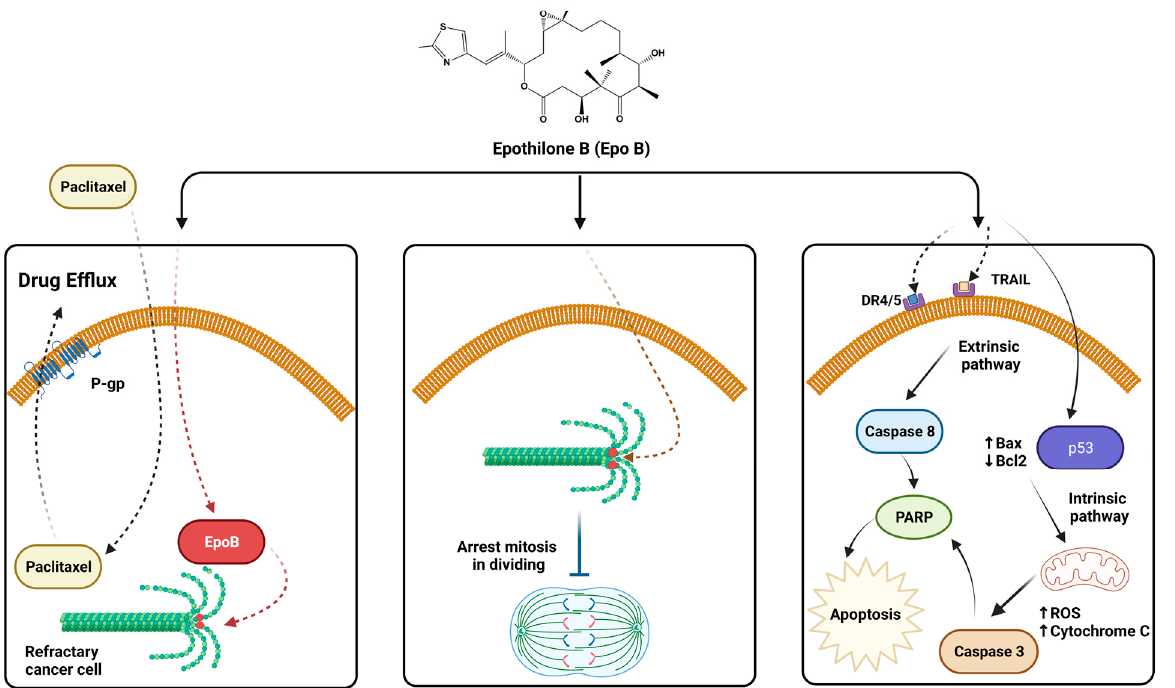
Figure 4. Mechanisms of action of epothilones. ( left ) Evasion of MDR-associated resistance. ( centre ) Stabilization of microtubules and inhibition of mitosis. ( right ) Induction of apoptosis.